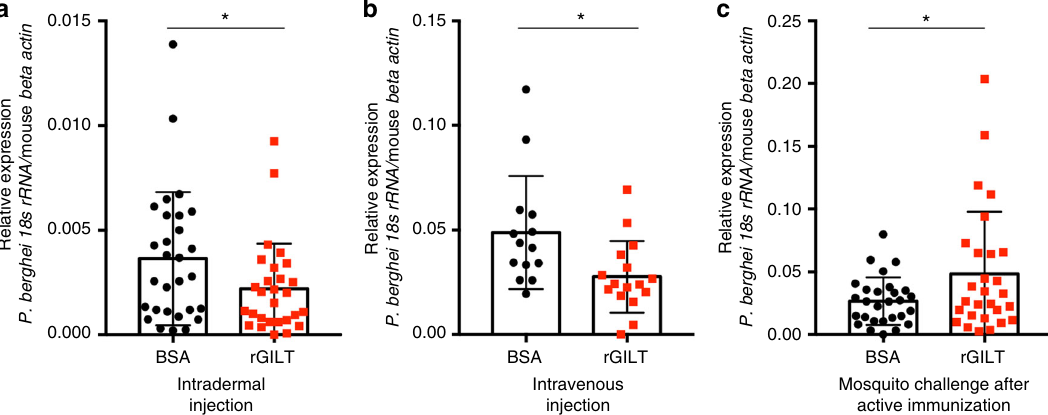
Fig. 7 MosGILT negatively impacts the transmission of P. berghei sporozoites. a Liver Plasmodium burden 40 hours after intradermal injection of 2500 P. berghei sporozoites incubated with either rGILT or BSA (100 µ g/ml each). Data pooled from fi ve independent experiments (mean ± SD, n = 29 BSA, n = 28 rGILT, Welch ’ s t -test, * p < 0.05). b Liver Plasmodium burden 40 hours after intravenous injection of 2000 rGILT or BSA-treated sporozoites (100 µ g/ml each). Data are pooled from two independent experiments (mean ± SD, n = 14 BSA, n = 16 rGILT, Welch ’ s t -test, * p < 0.05). c Mice actively immunized with either rGILT or ovalbumin (OVA) were each bitten by three P. berghei -infected A. gambiae mosquitoes. The liver Plasmodium burden was analyzed 40 hours after the infectious bites. Data are pooled from three independent experiments (mean ± SD, n = 29 Ova, n = 29 rGILT, Welch ’ s t -test, * p <